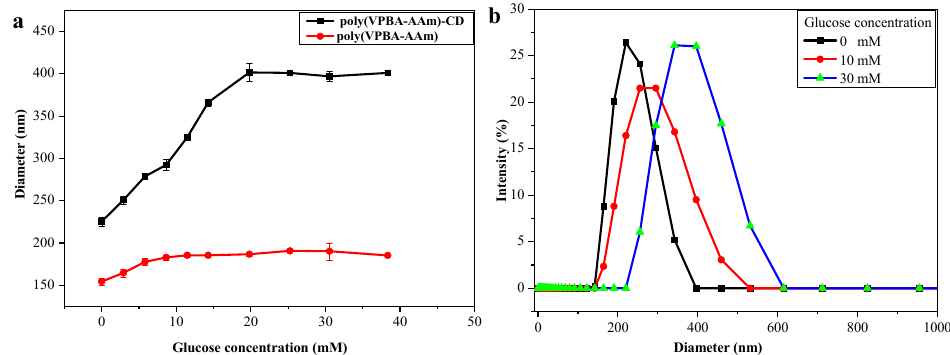
Figure 5. ( a ) Average Rh values (scattering angle θ = 90 ◦ ) of poly(VPBA-AAm) and poly(VPBA-AAm)- CD at different glucose concentrations (PBS, pH = 7.4). ( b ) Size distribution of poly(VPB-AAm)-CD in PBS (pH = 7.4) with glucose concentrations of 0, 10 and 30 mM, respectively.